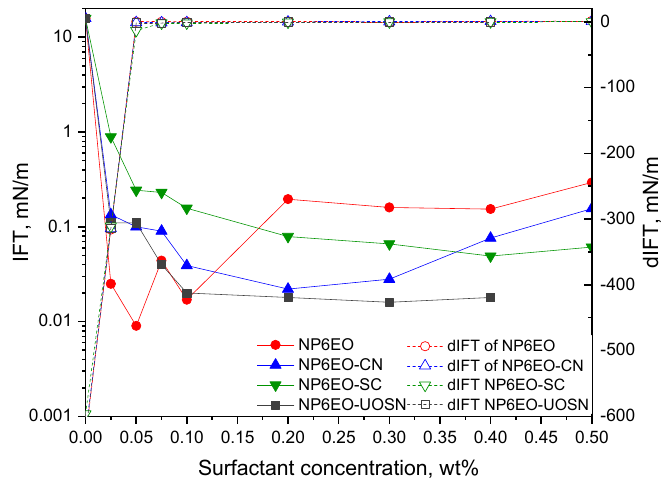
Figure 4. Interfacial tension of NP6EO, NP6EO–CN, NP6EO–SC, NP6EO–UOSN with different concentrations. Twenty percent NaCl and 1st derivative of IFT function (dIFT).